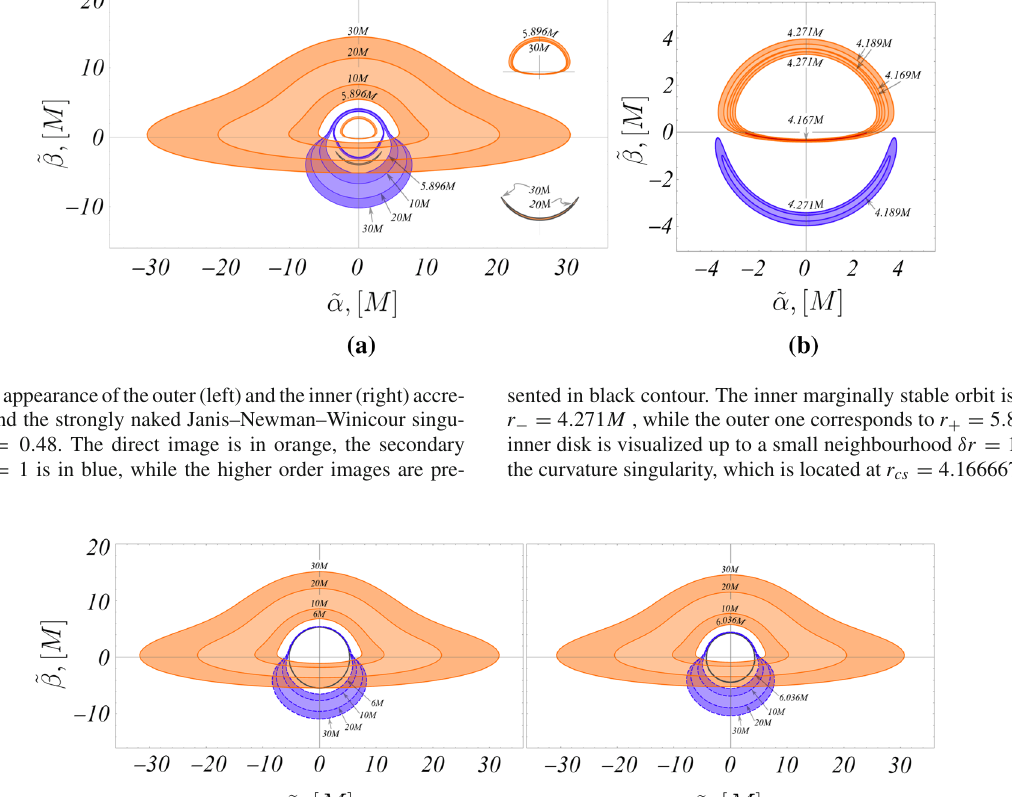
observer is located at r = 5000 M and inclination angle i = 80 ◦ . The black circle represents the optical appearance of the photon sphere. We use the same conventions as in Fig.